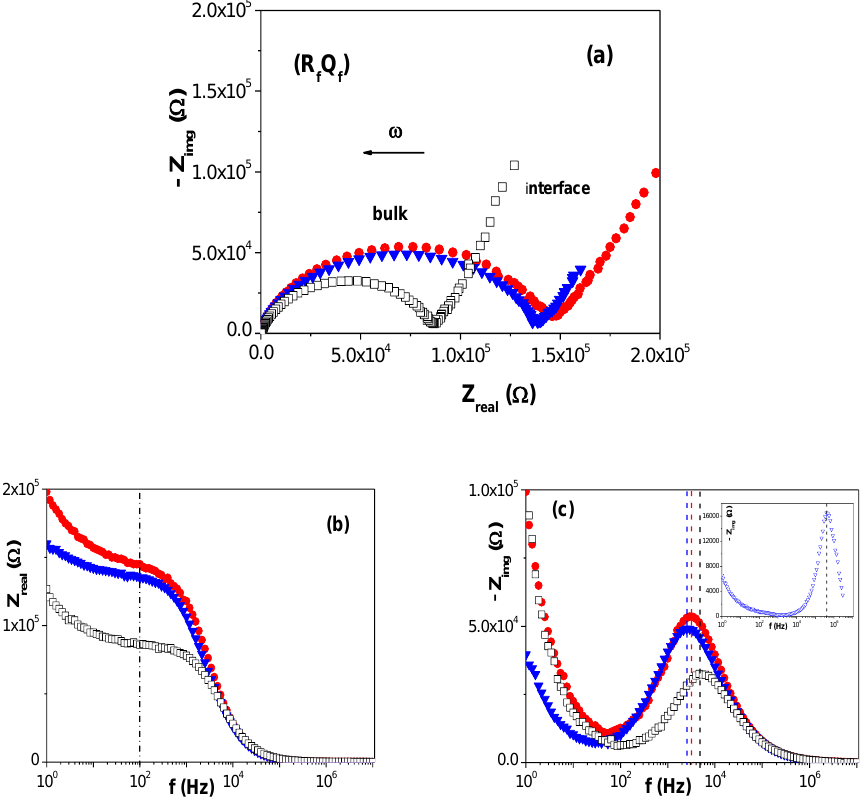
Figure 7. Impedance diagrams for the RC/BMIMPF 6 film ( ● ), the RC/AliquatCl film ( ▼ ) and the RC support (□). ( a ) Nyquist plot (−Z img vs. Z real ); ( b ) and ( c ) Bode plots (Z real vs. frequency) and (−Z img vs. frequency), respectively. Insert in ( b ) and ( c ): Bode plots for the AlqCl IL ( ∇ ). The fit of the IS data points represented in Figure 7a to a parallel association of re- sistance (R f ) and a non-ideal capacitor (Q f ) for both RC/IL films (R f Q f equivalent circuit) allowed us to determine the electrical resistance and equivalent capacitance (C eq ) values [44], and from these results, the conductivity ( σ f ) and dielectric constant ( ε f ) of each RC/IL